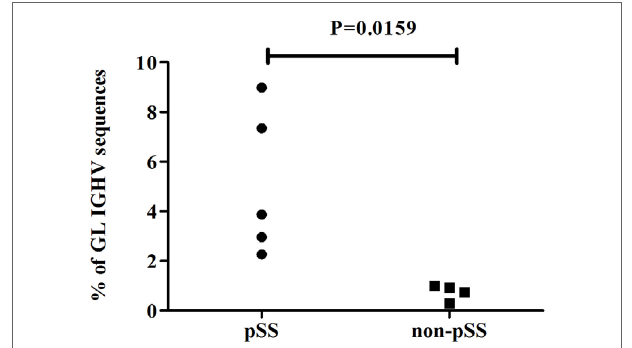
FigUre 2 | Percentage of germline ( ≤ 1 nucleotide difference from GL gene) encoded IGHV sequences in parotid gland biopsies of pSS patients and non-pSS sicca controls.